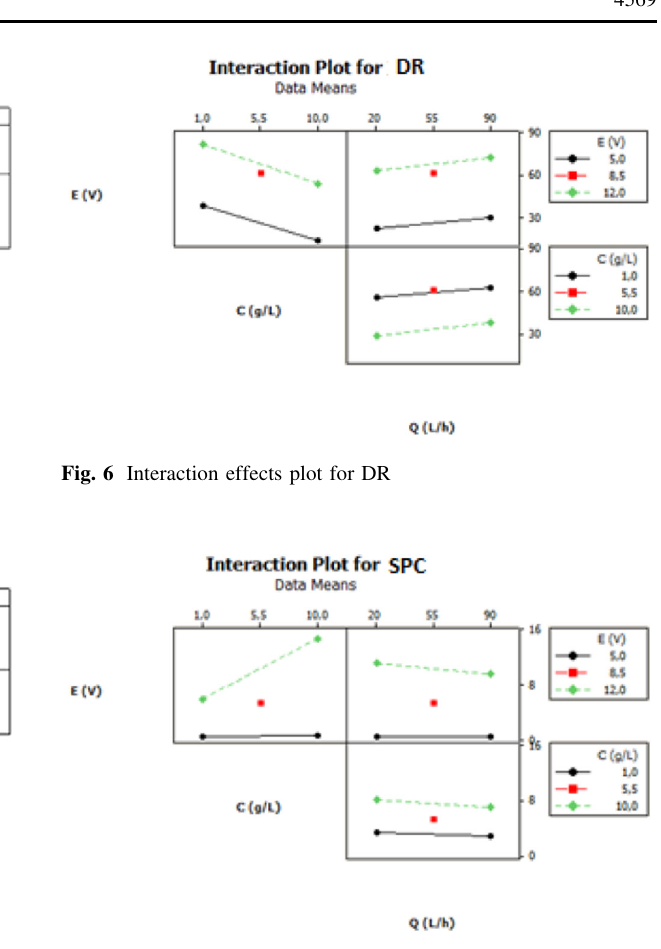
Fig. 5 Main effects plot for SPC